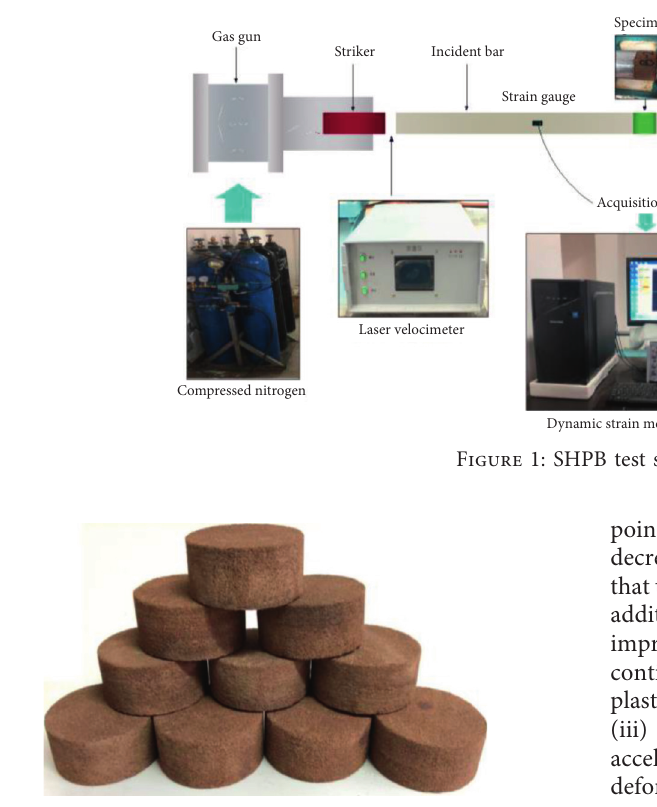
Figure 2: Standard sandstone